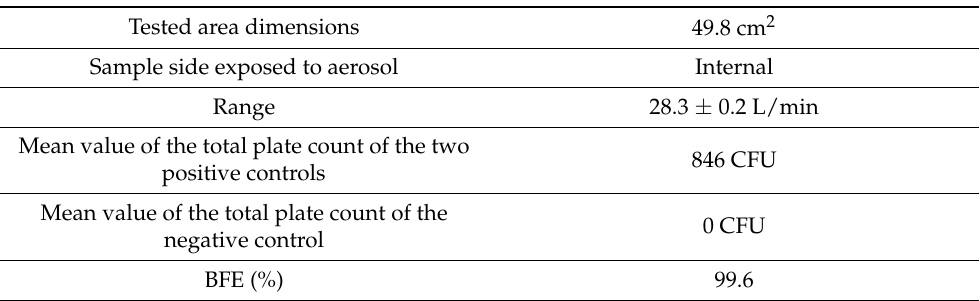
Table 2. Individual BFE values of FFP2 A. All samples exceeded the breathability and bacterial filtration tests (BFE). A BFE value greater than or equal to 98% was found on all samples, as required by the UNI EN 14683: 2019 + AC: 2019 standard.